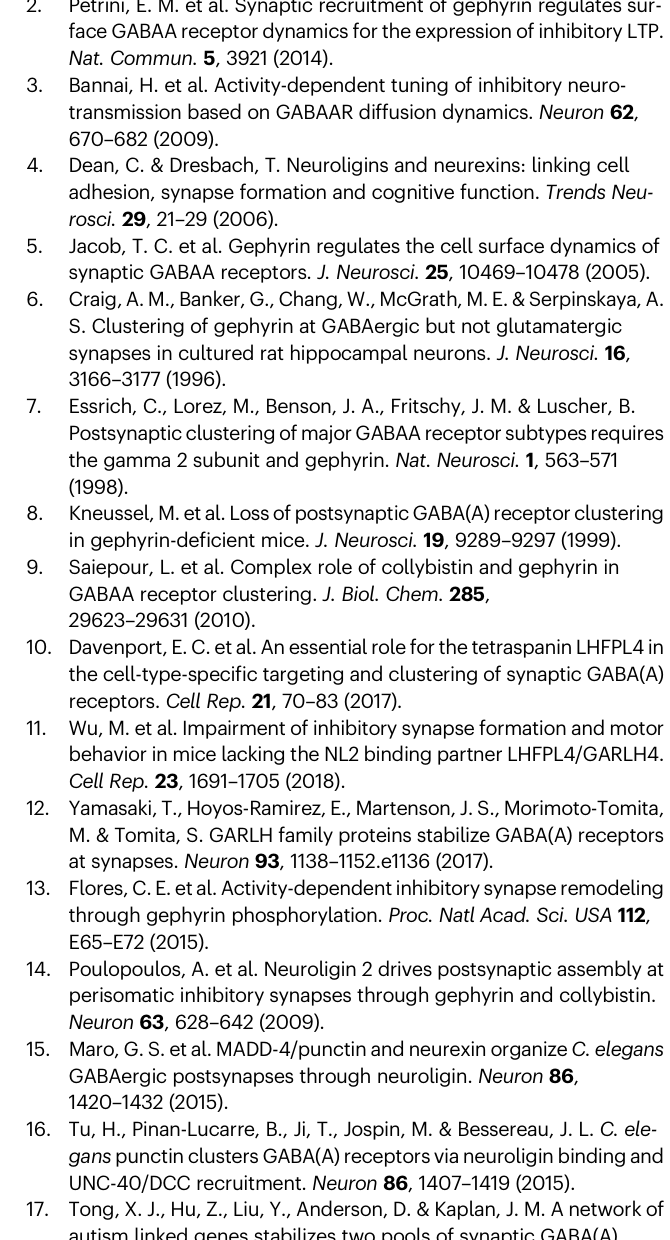
Fig. 3, which marked with letters and data corresponding to scatter plots labeled with different letters are signi fi cantly